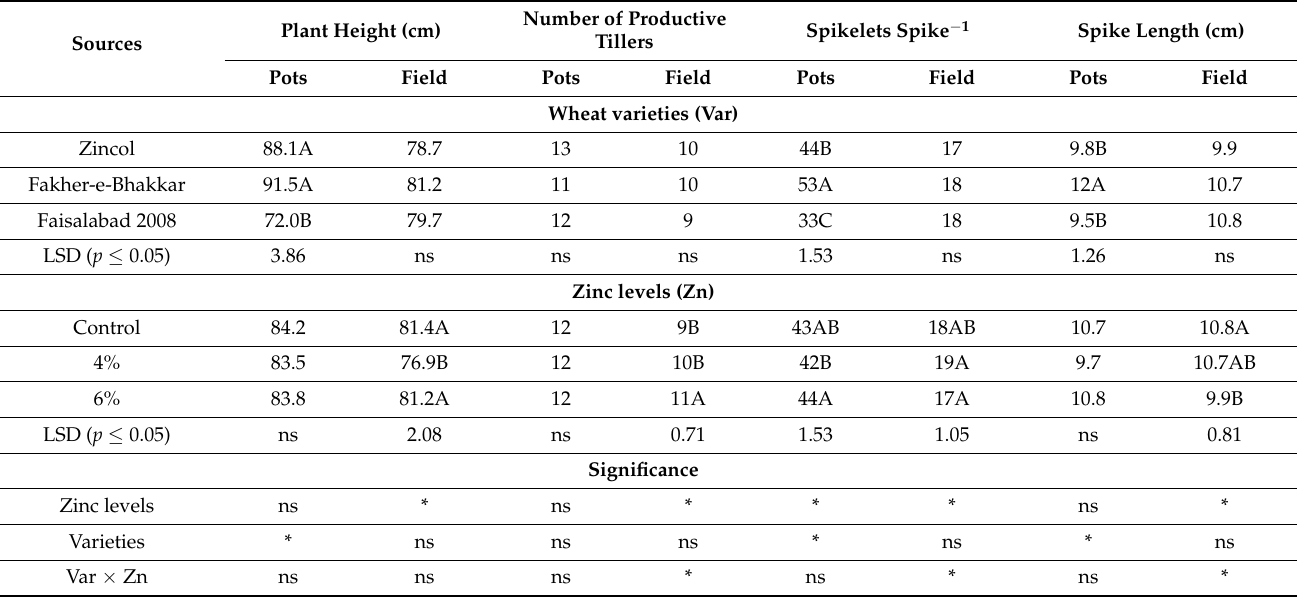
Table 1. Plant height, number of productive tillers, number of spikes, number of spikelet per spikes, and spike length as affected by different foliar applied zinc and wheat varieties grown under controlled